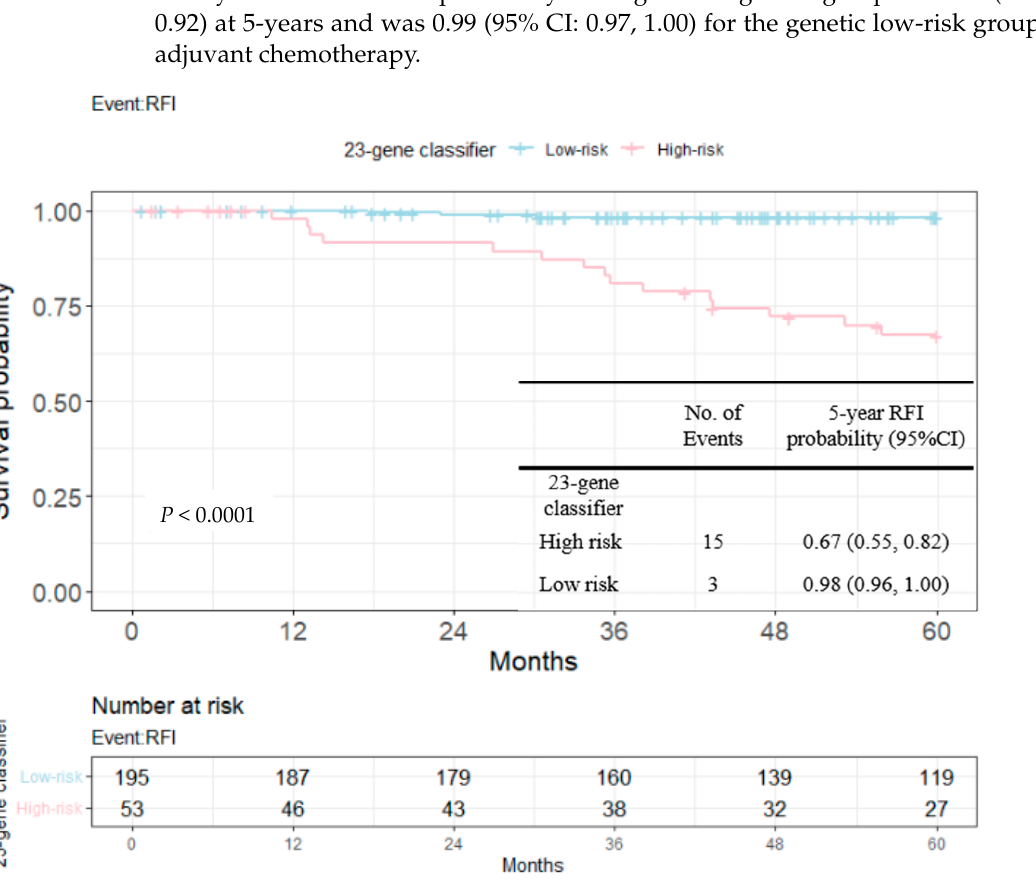
Figure 3. Kaplan–Meier plot for RFI within 5 years to compare the partition of 23-gene classifier. Blue: genetic low-risk group; red: genetic high-risk group.